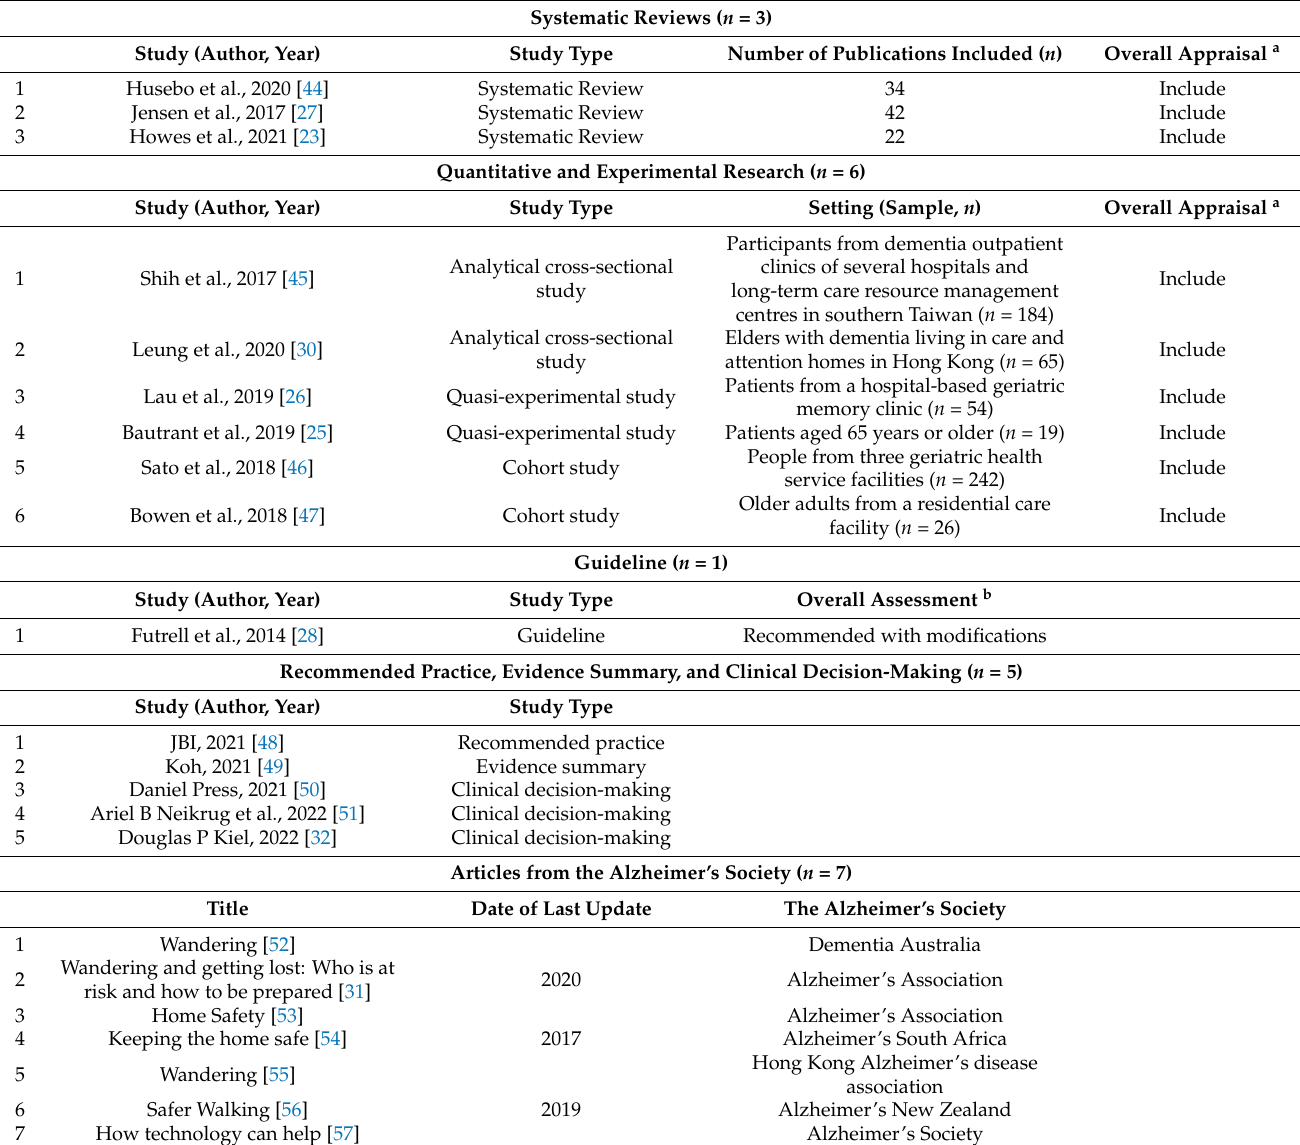
Table 2. Overview and characteristics of the publications included ( n =